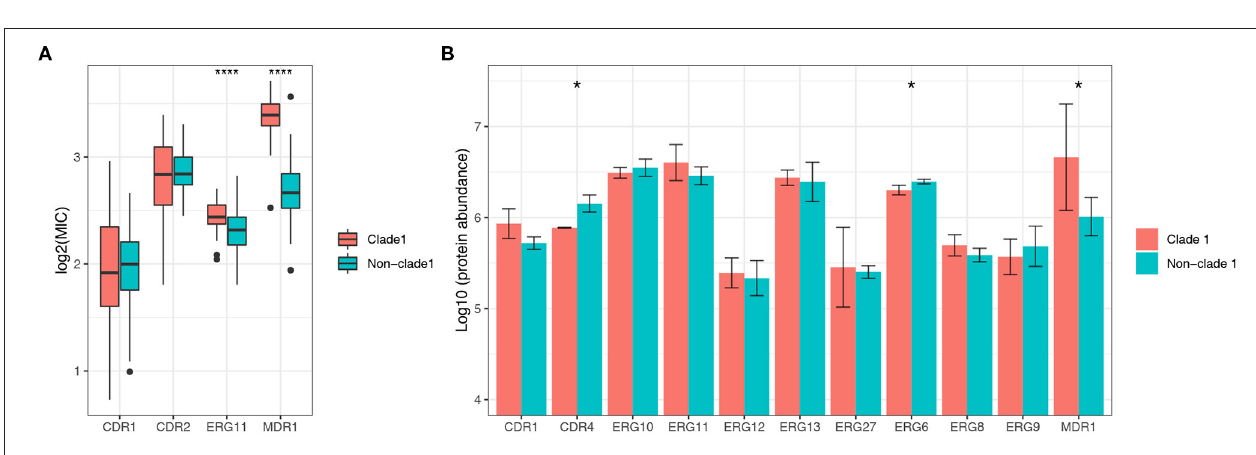
FIGURE 4 | The expression level of the multidrug resistance gene MDR1 of C. albicans in MLST clade 1 isolates was significantly higher than that in non-clade 1 isolates. The mRNA expression levels of ERG11, CDR1, CDR2, and MDR1 were determined in 306 isolates (A) , while ERG11 and MDR1 exhibited significantly higher expressions in clade 1 than in other clades (**** p < 0.0001). Consistently, the proteomics results (B) also showed that the expression of MDR1 protein was significantly higher in clade 1 (* p < 0.05). The CDR4 and ERG6 proteins also presented significant differences in expression between clade 1 and non-clade 1